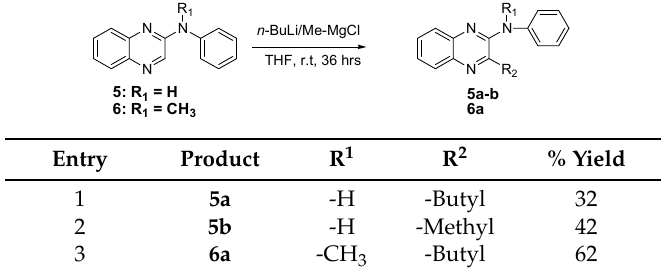
Table 3. Nucleophilic substitution on N -benzylquinoxalin-2-amine.